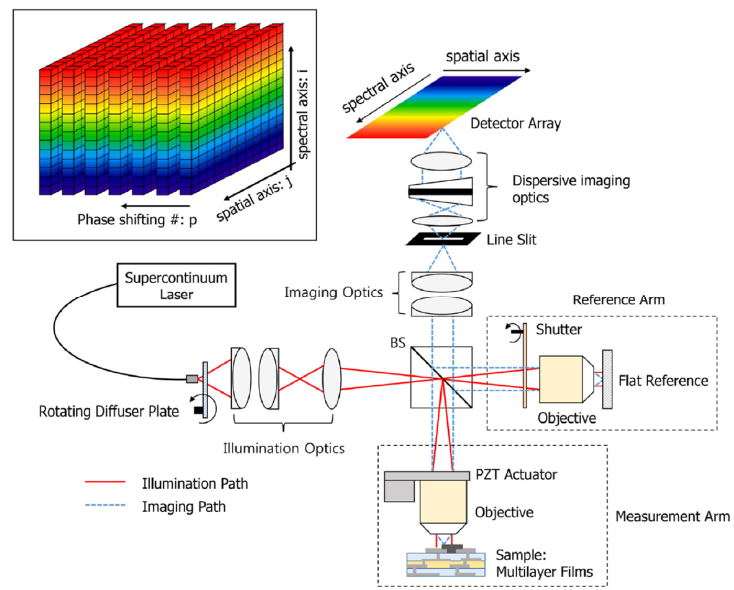
Figure 12. Imaging spectroscopic reflectometry combined with SRI originated from Ref.